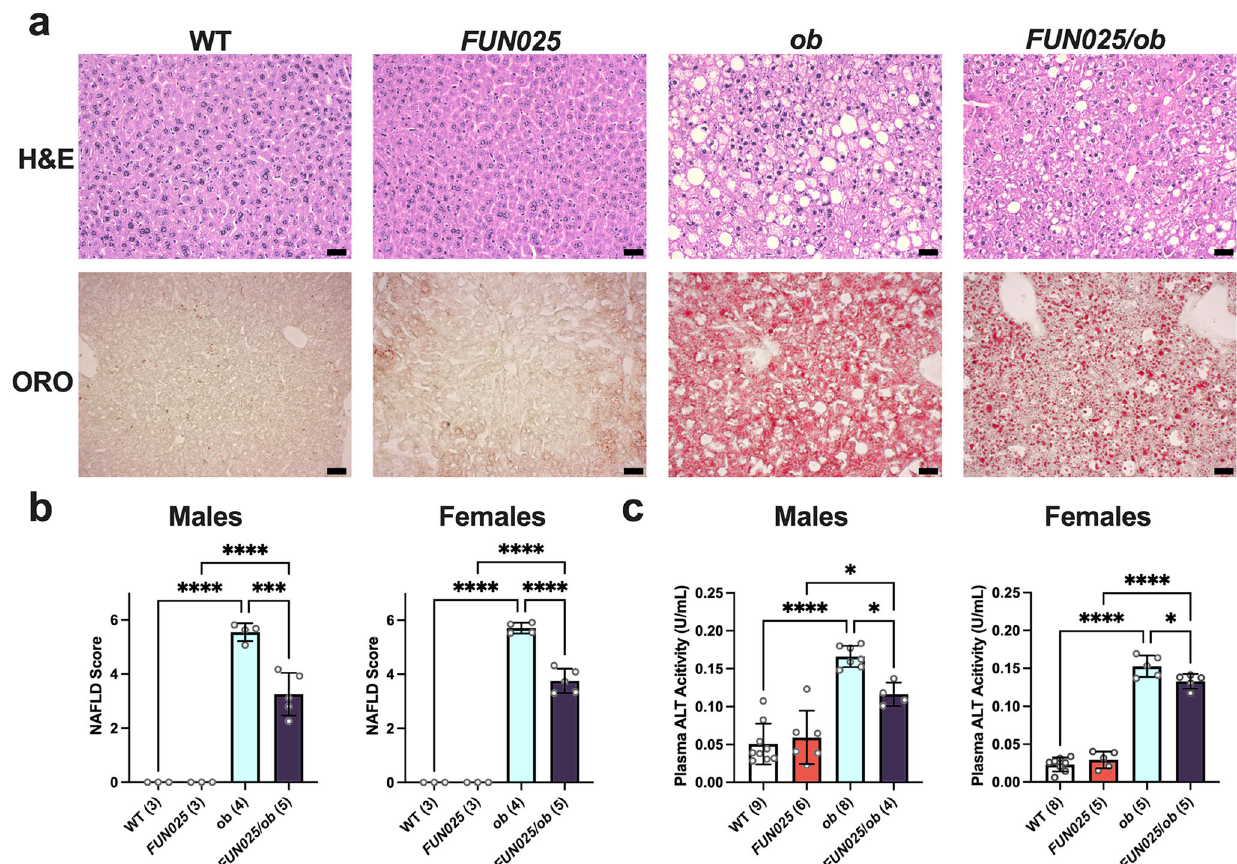
Fig. 8 Tmem135 mutation reduces leptin mutation-induced liver phenotype. a Representative 20x images of hematoxylin and eosin (H&E) and oil red o (ORO) stained liver sections from 3-month-old male WT, Tmem135 FUN025/FUN025 ( FUN025 ), Lep ob/ob ( ob ), and Tmem135 FUN025/FUN025 / Lep ob/ob ( FUN025/ ob ) mice. Scale Bar = 100 microns. b Non-alcoholic fatty liver disease (NAFLD) severity scores. c Plasma ALT activity. Number in parentheses represent the N of independent mouse samples per genotype used in the experiment. Dots represent individual data points. Asterisks (*, ***, and ****) indicates a P < 0.05, P < 0.01, P < 0.001, and P < 0.0001 signi fi cance by post hoc Tukey test following a signi fi cant difference detected by one-way ANOVA. Data are presented as mean ±